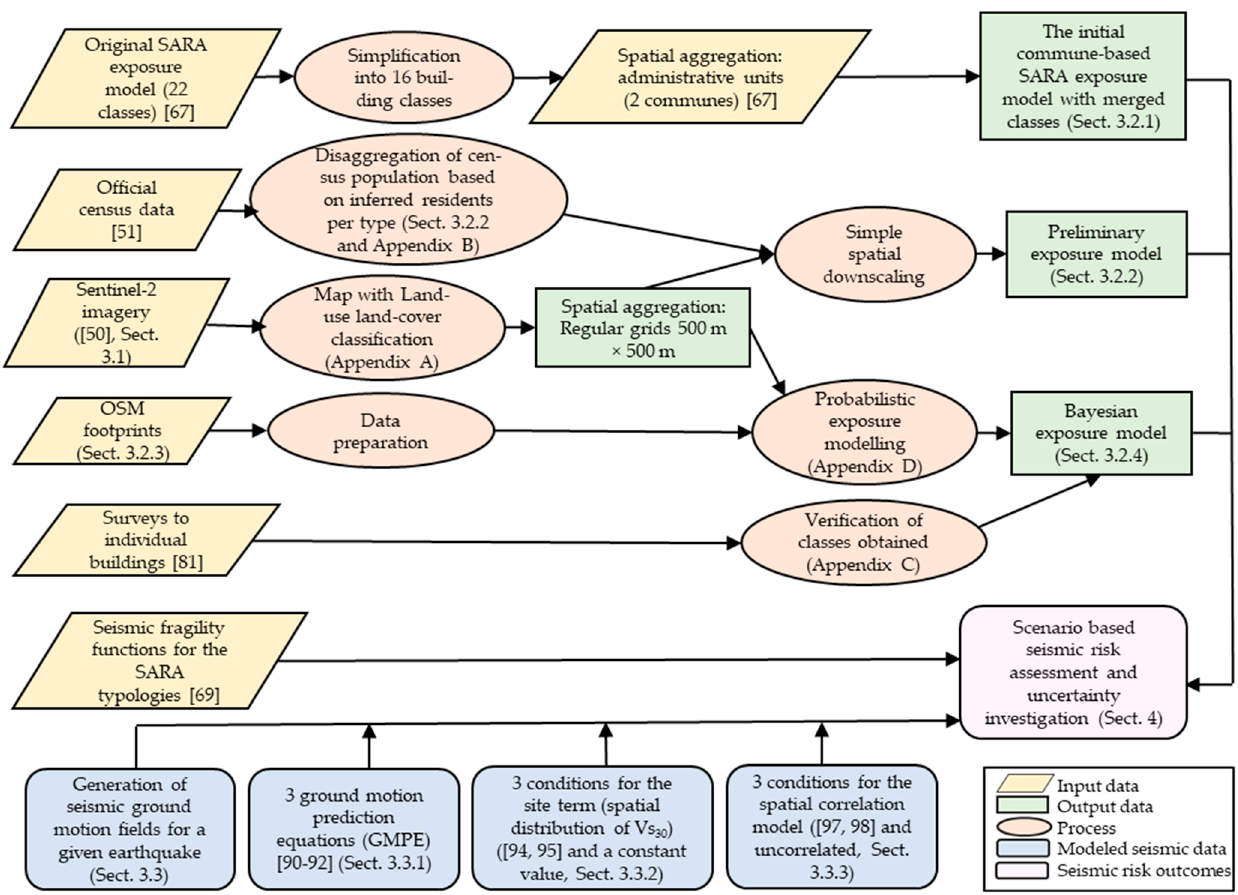
Figure 2. Flowchart outlining the input data gathered, the processes, and the three resulting residential building exposure models for Valparaíso (Chile) we will be presenting throughout this study. These exposure models, together with the parametric ground motions, are used as inputs for the sensitivity analysis in scenario-based seismic risk in the last stage of this study.